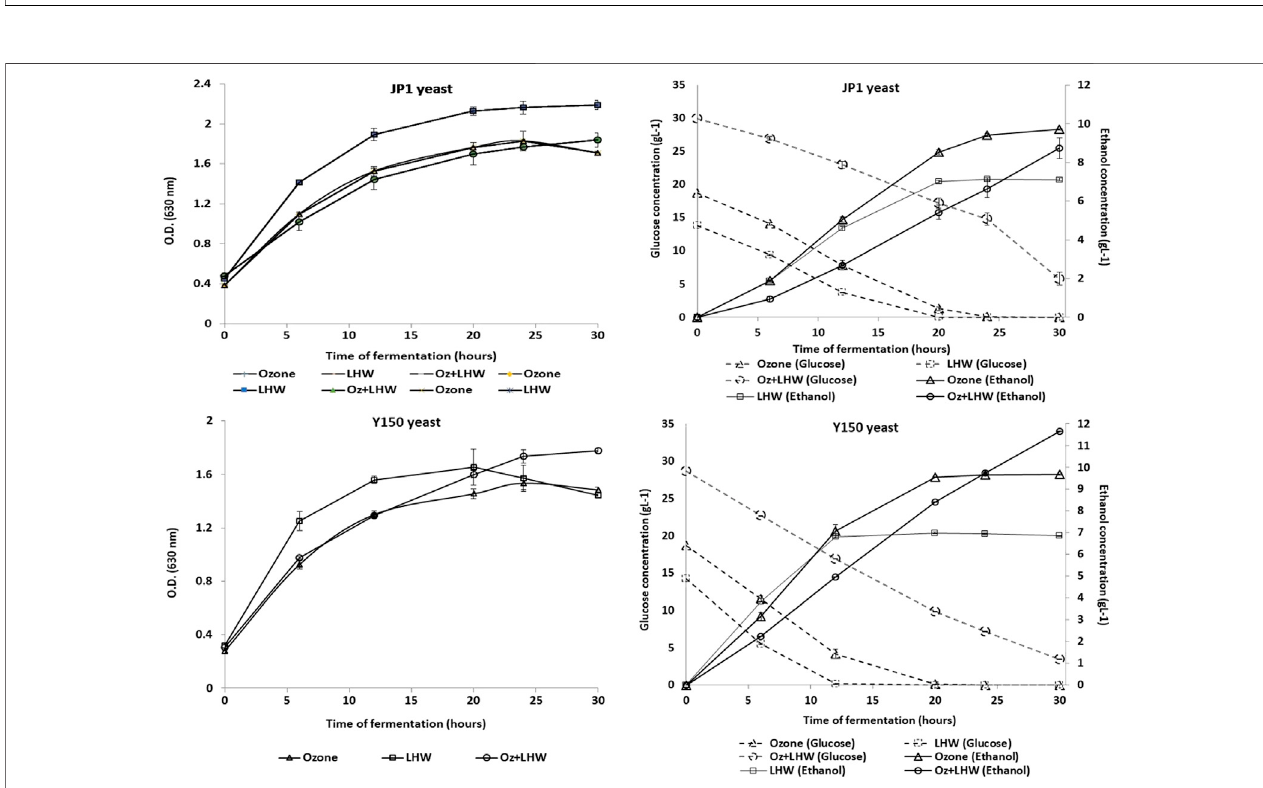
FIGURE 5 | Kinetics of yeasts JP1 and Y150 in alcoholic fermentation of sugarcane bagasse hydrolysate pretreated by individual and combined Ozonolysis and LHW approaches.